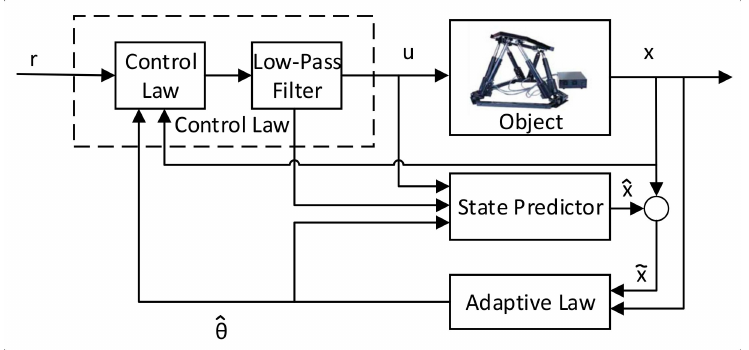
Figure 1. Structure diagram of the L 1 adaptive flight simulation control